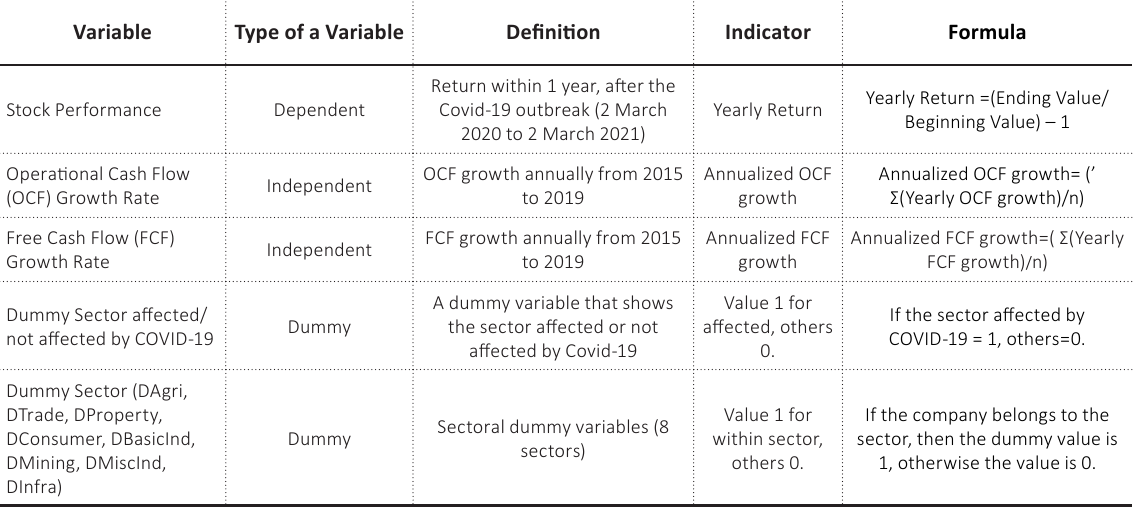
Table 2. Variable